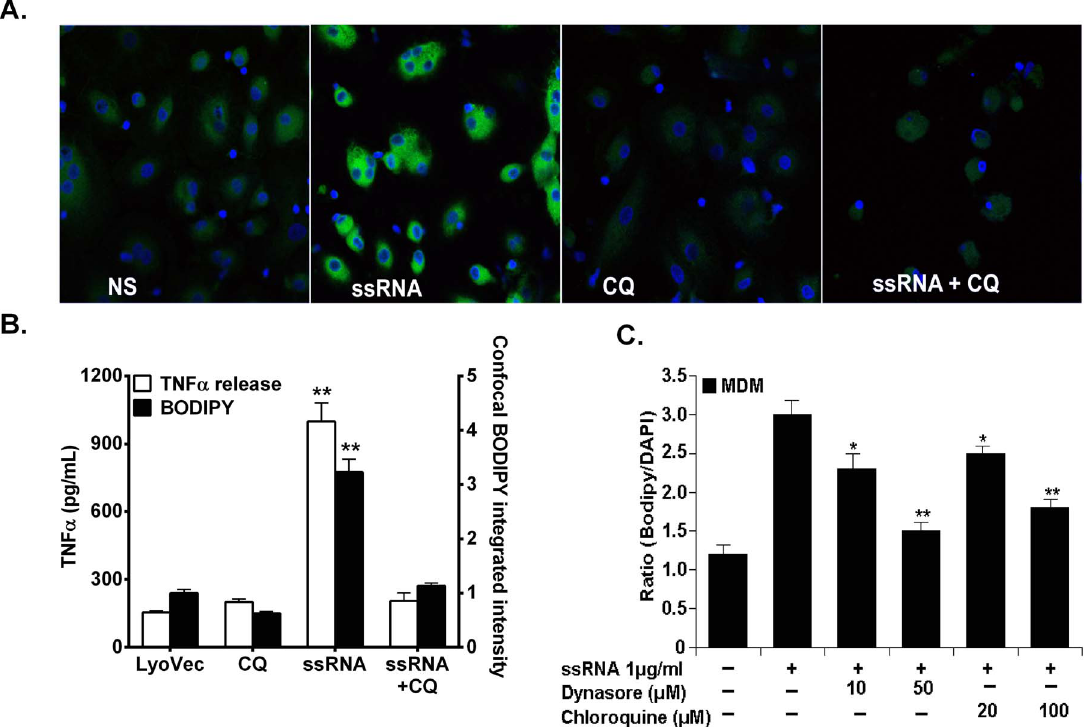
Figure 4. Dependence of HIV-derived ssRNA-induced foam cell formation and TNF a in macrophages on endocytosis and endosomal acidification. MDMs were pretreated with 100 m M chloroquine or 50 m M dynasore for 1 h followed by incubation with 1 m g/ml HIV- ssRNA for 24 h and stained with BODIPY and DAPI (A, C) and cell free supernatant analyzed for TNF a by ELISA and integrated fluorescence intensities for BODIPY in each cell of the confocal micrographs (B). Data shown is a representative experiment with similar results from four different healthy uninfected subjects. *p , 0.05, **p , 0.01 compared to vehicle control (LyoVec) or HIV-ssRNA alone. NS, non-stimulated vehicle control (LyoVec); CQ, chloroquine; DY,